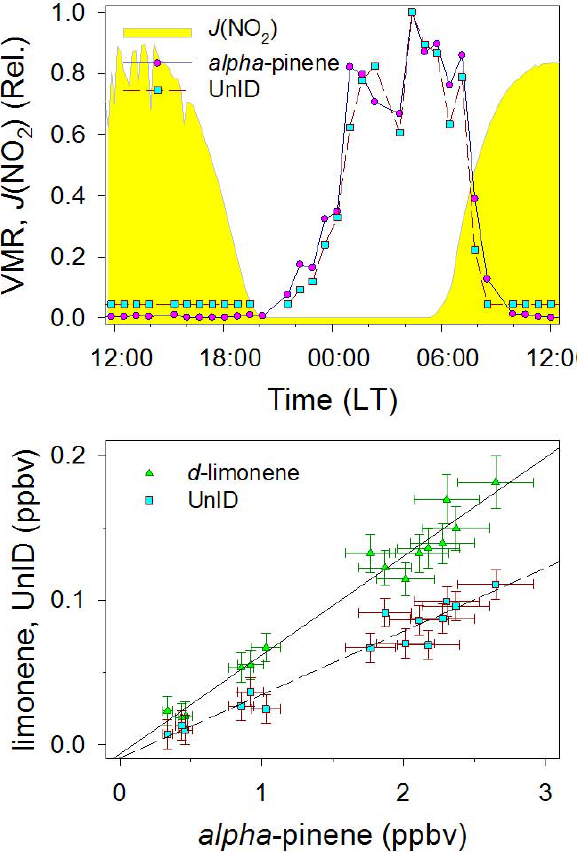
Fig. 4. Comparison of trends in the mixing ratios of α -pinene and an unidentified (UnID) compound (assumed to be C 10 ) during the pe- riod from 2 August, 12:00 LT to 3 August, 12:00 LT; (a) time series of relative mixing ratios; (b) linear regression of absolute mixing ratios. The J (NO 2 ) data in (a) are 10min averages and delineate daytime and nighttime periods. In (b) the correlation between the d -limonene and α -pinene mixing ratios is shown for comparison. The coefficients of determination ( r 2 ) for the regression lines were 0.97 and 0.95 for d -limonene and UnID, respectively. Error bars represent the greater of the measurement precision or LOD. Mix- ing ratios below the LOD were set to 0.5 × LOD in (a) and were excluded from the regression in